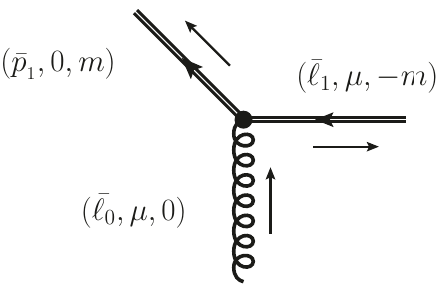
Figure 6 . To perform the unitarity cuts of the six dimensional propagators involving internal fermions, we allow the ( d 4) part, (cid:22) , of the loop momentum to flow in the fifth component and (cid:0) the mass term to flow in the sixth component, in order to easily impose momentum